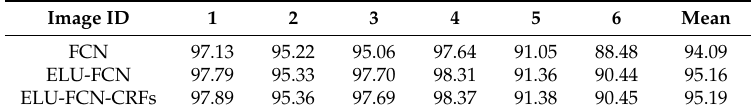
Table 2. F1-scores (%) of variations of the proposed techniques in selected regions of test images.